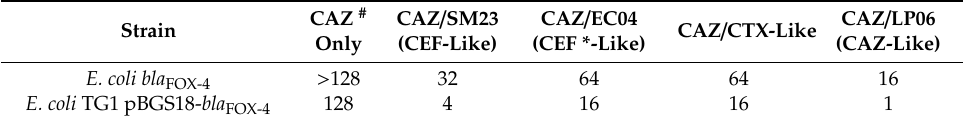
Table 2. Broth microdilutions Minimum Inhibitory Concentrations (MIC) results.